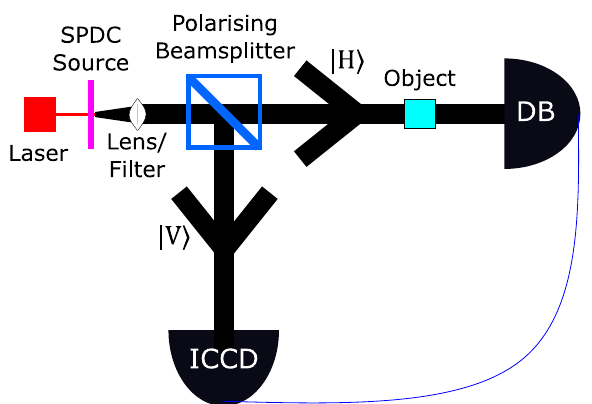
Fig. 1 A standard set-up for ghost imaging. Position-and- momentum-entangled photons are generated in pairs at the spontaneous parametric downconversion (SPDC) source from a laser beam, with conjugate polarisations (i.e. always in pairs of horizontal and vertical polarisation). A polarising beamsplitter sends the vertically polarised photon to an intensi fi ed charge-coupled device (ICCD) camera (which records in high resolution its arrival position) and sends the horizontally polarised photon via a sample to be imaged, to a bucket detector (DB). By recording coincidences between the detections at the ICCD and the bucket detector, the sample can be “ ghost imaged ”